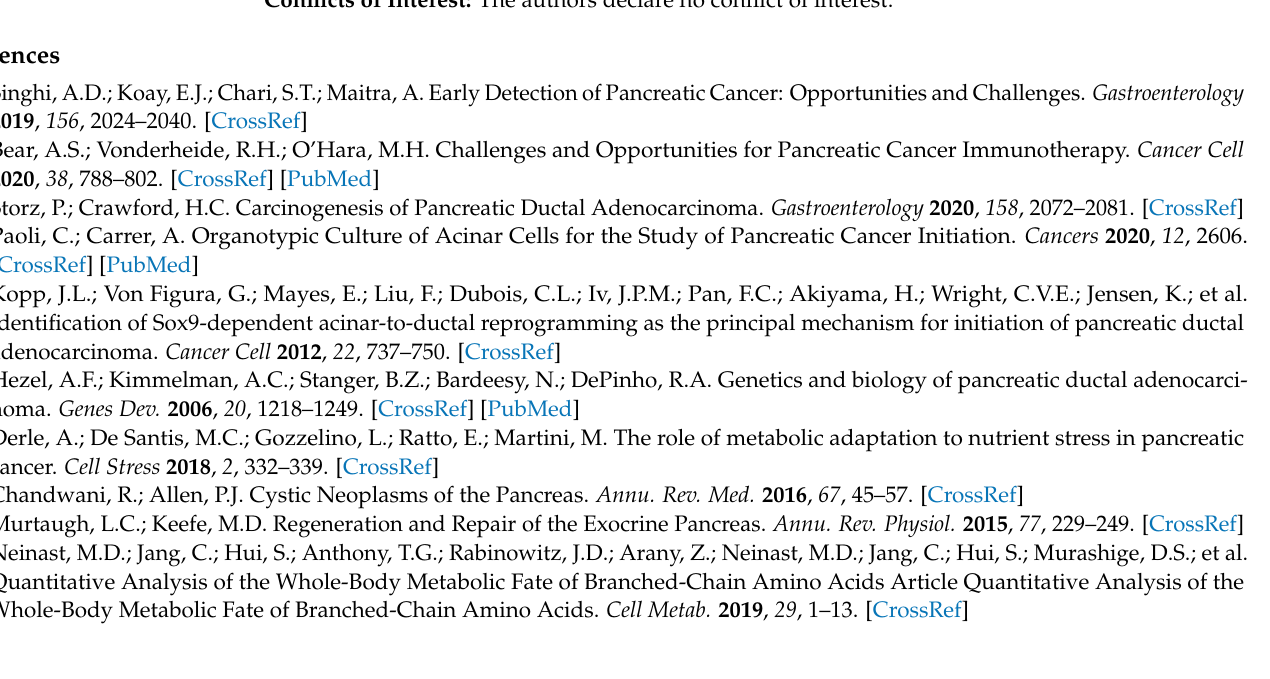
Figure S2: Cholesterol supplementation does not promote PKA activation in pancreatic cancer